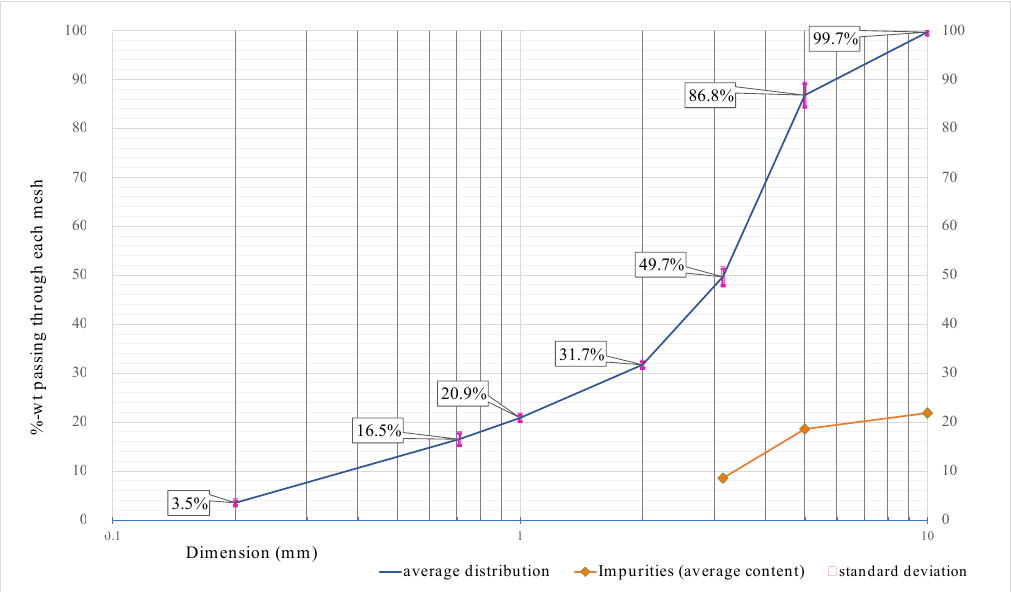
Figure 3. Particle-size distribution of the waste polyurethane foam.